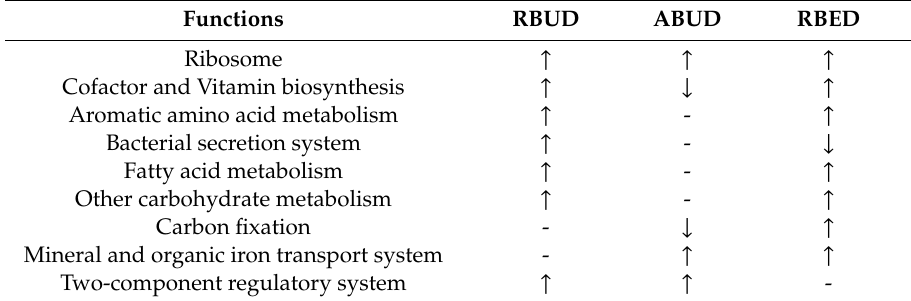
Table 1. The enriched common function characteristics of RBUD, ABUD and RBED. Functions RBUD ABUD RBED Ribosome ↑ ↑ ↑ Cofactor and Vitamin biosynthesis ↑ ↓ ↑ Aromatic amino acid metabolism ↑ - ↑ Bacterial secretion system ↑ - ↓ Fatty acid metabolism ↑ - ↑ Other carbohydrate metabolism ↑ - ↑ Carbon fixation - ↓ ↑ Mineral and organic iron transport system - ↑ ↑ Two-component regulatory system ↑ ↑